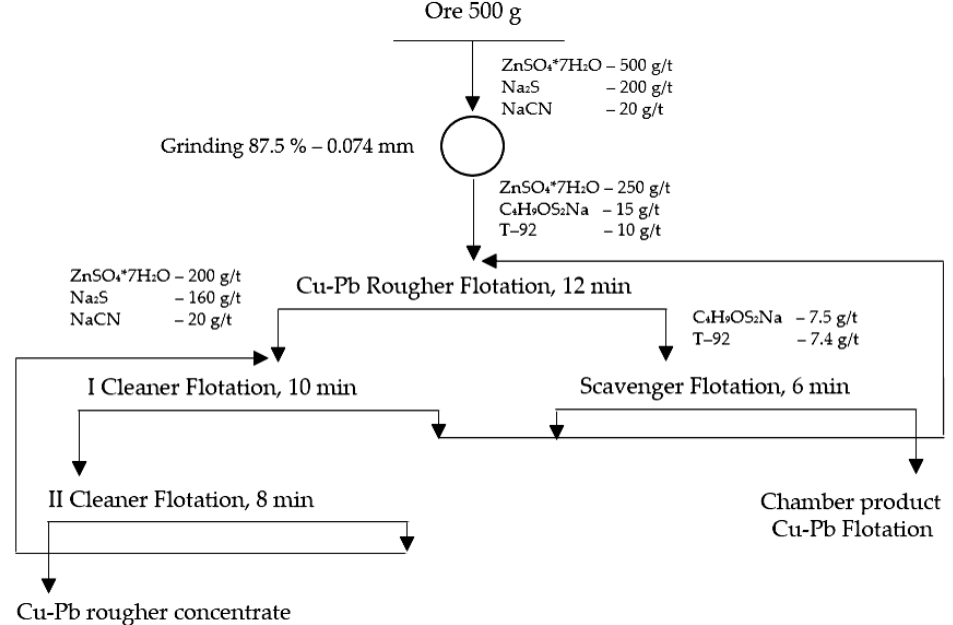
Figure 1. Scheme of copper-lead rougher flotation of